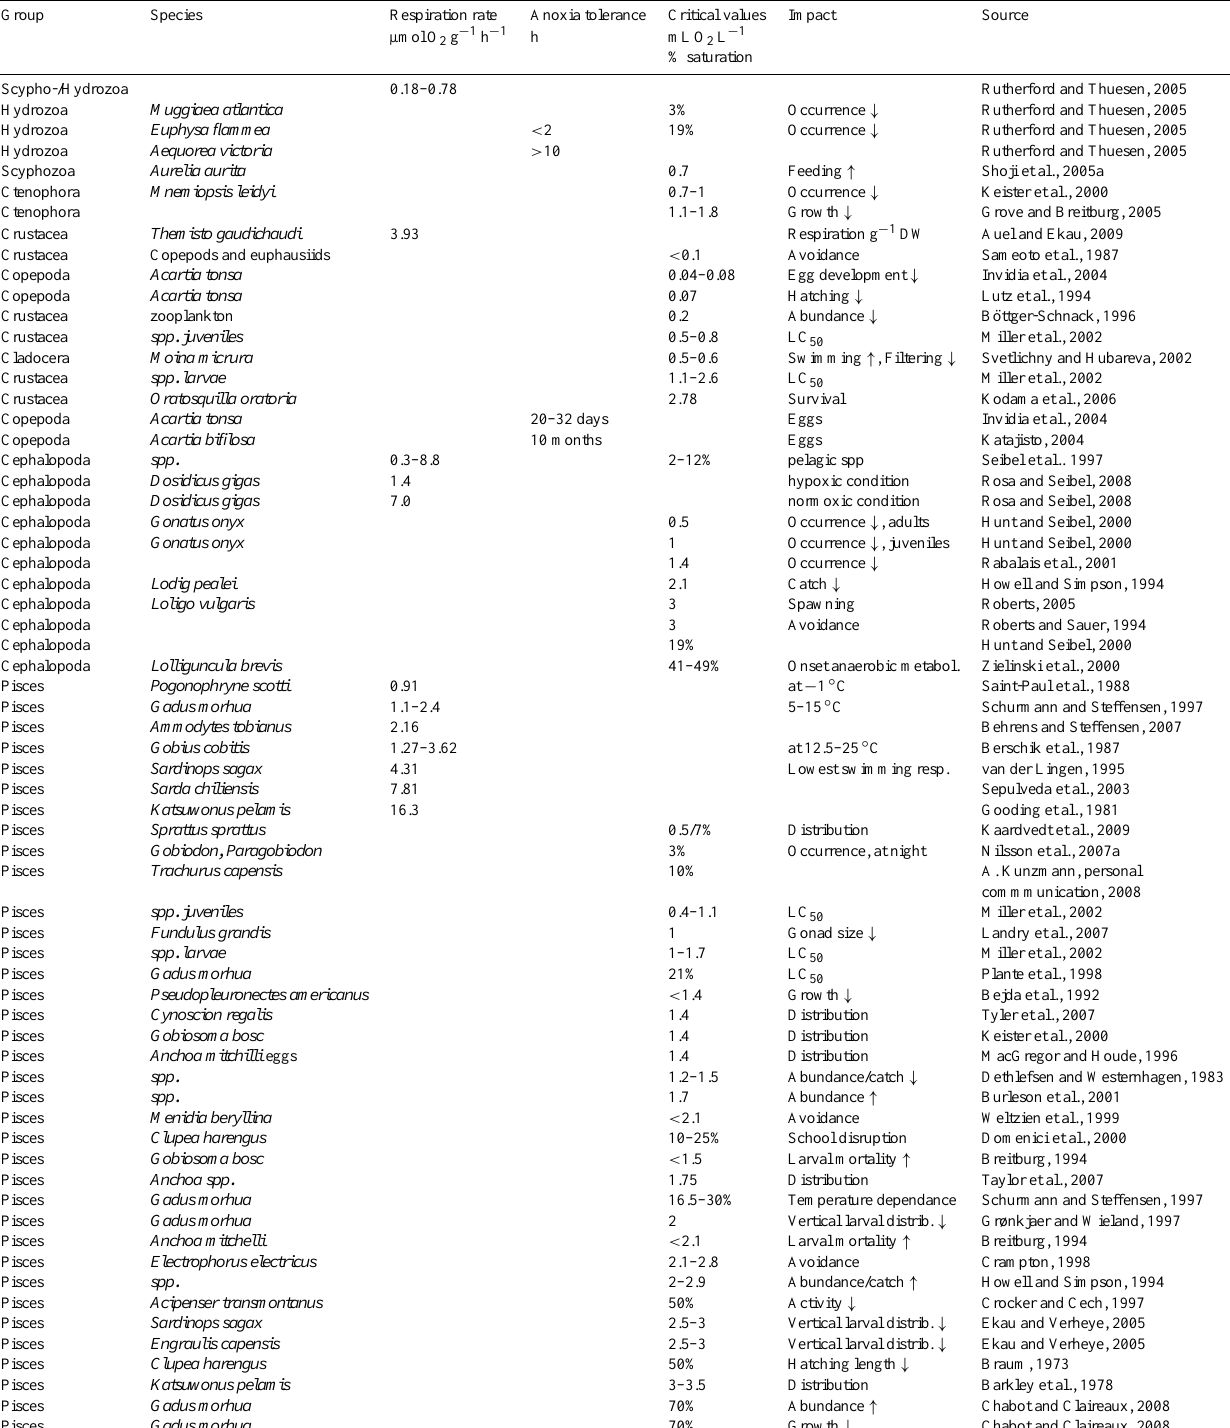
Table 2. A list of oxygen consumption rates, anoxia tolerance and critical DO values for a selected number of species. Arrows in column 6 indicate the direction of impact when oxygen drops below the critical